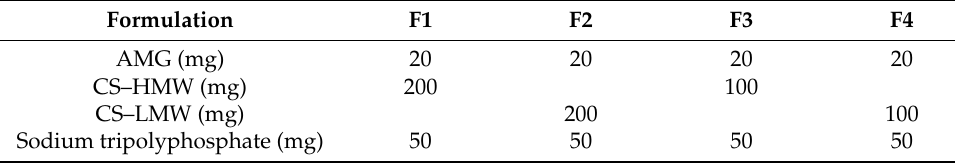
Table 1. AMG–CS–NPs